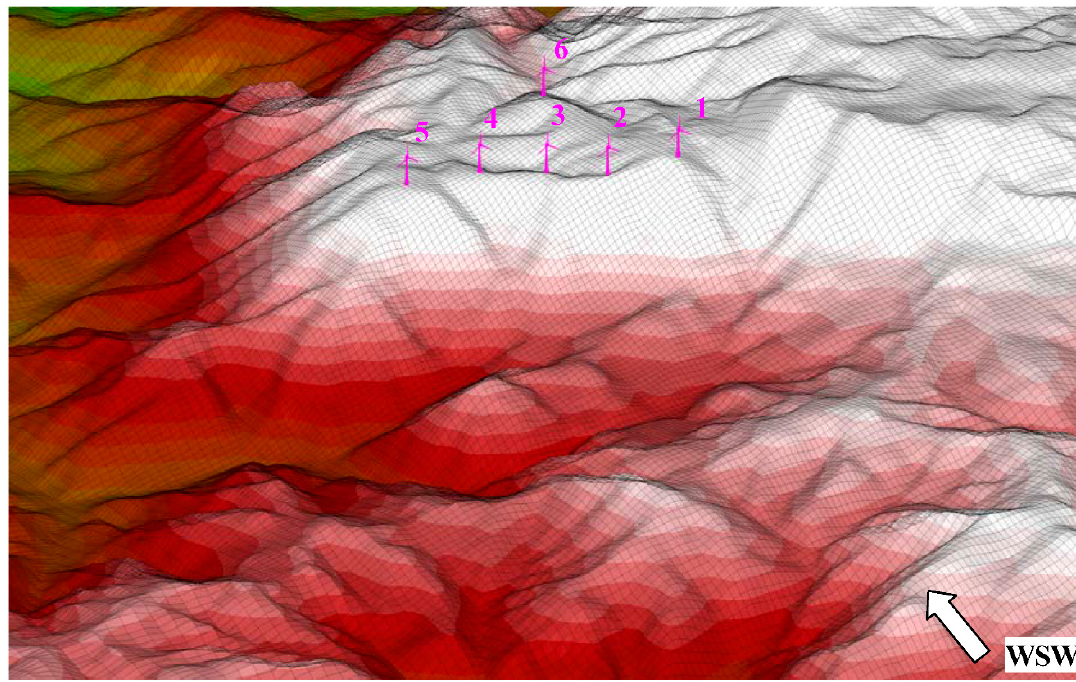
Figure 4. Computational grid in the vicinity of the wind turbines.